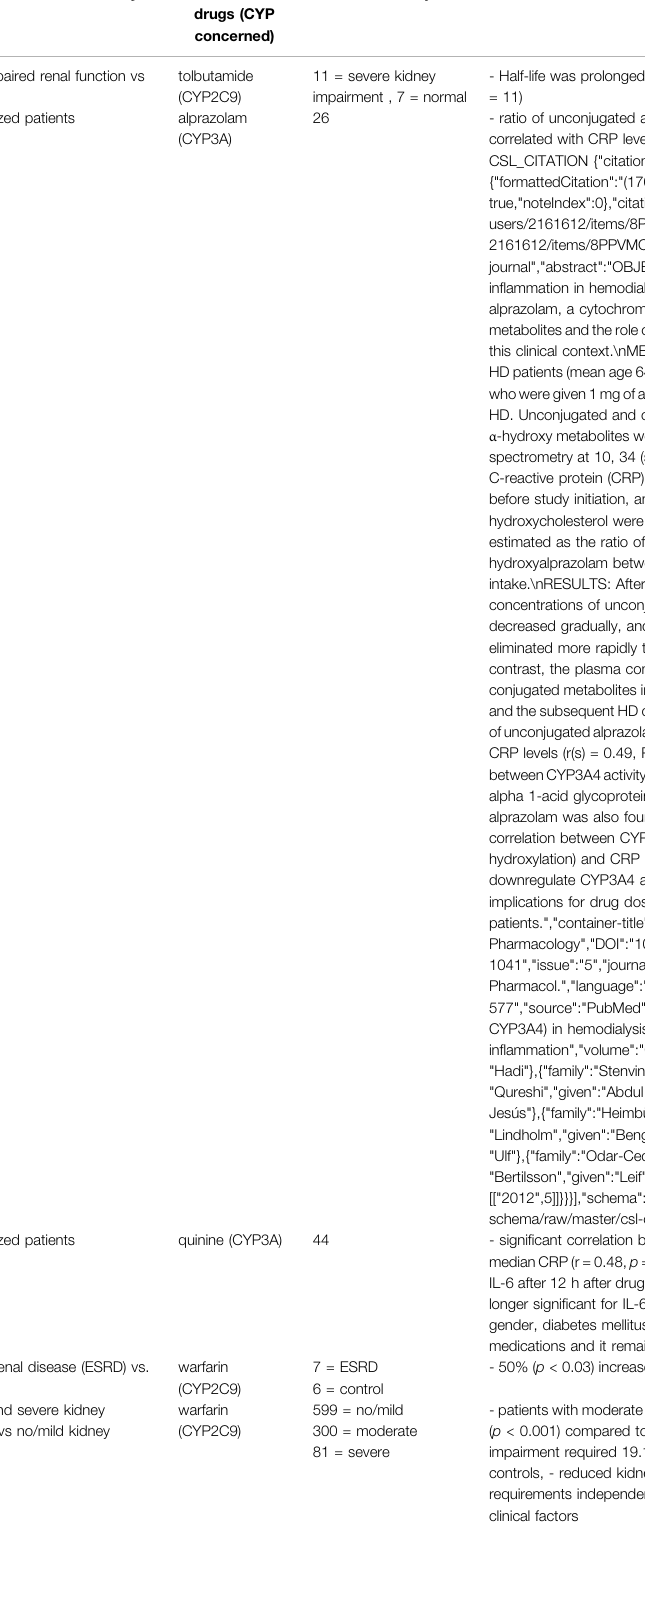
TABLE 4 | Impact of renal diseases on CYP substrates, explained totally or partially by modulation of CYP activity. In fl ammation characterized